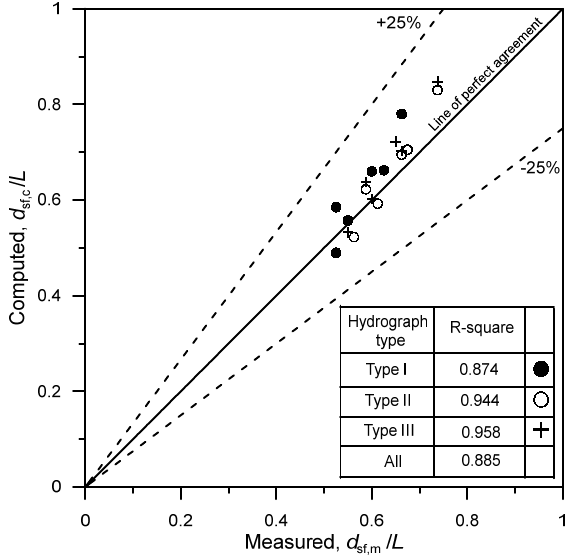
Figure 12. Comparison of final scour depth under unsteady flow conditions between the proposed model and the present experimental data. Table 4. Comparison of observed and computed (Equation (1)) scour depth at abutment under un- steady flow.